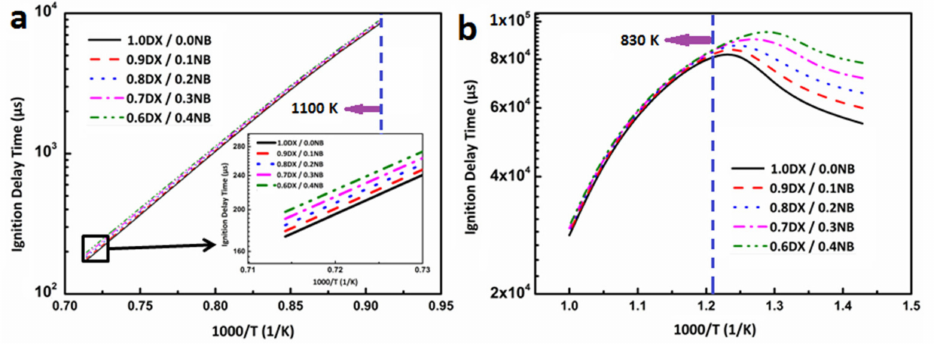
Figure 9. ( a ) Effect of DX and n-butanol blending ratio on high-temperature ignition delay; ( b ) Effect of DX and n-butanol blending ratio on low-temperature ignition